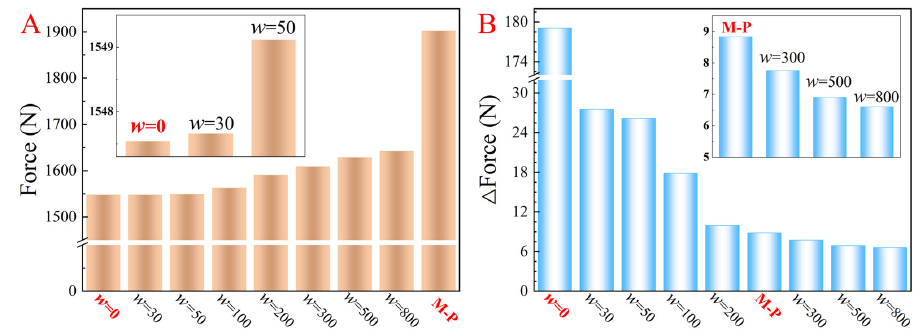
Figure 12. The entire trajectory’s simulation results of MCPM ( M = 1, N = 2) using different optimization methods: ( A ) maximum driving force and ( B ) maximum driving force mutation.